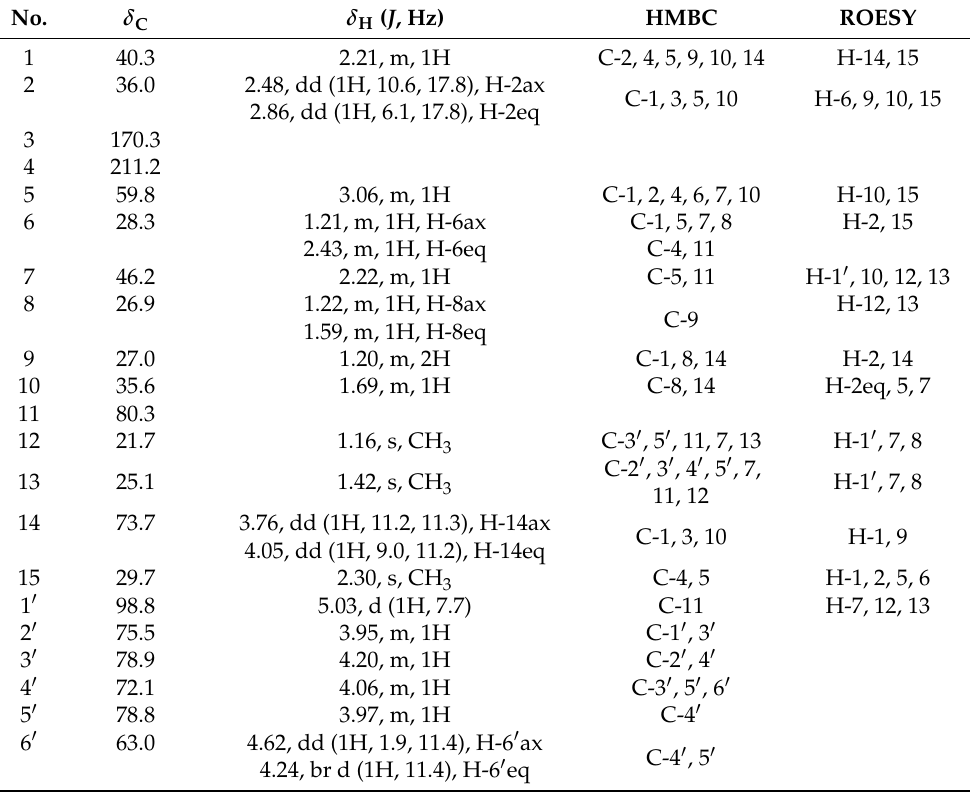
Table 1. The 1 H-NMR (500 MHz), 13 C-NMR (125 MHz), HMBC, and ROESY spectra data for compound 1 ( δ , TMS, pyridine- d 5